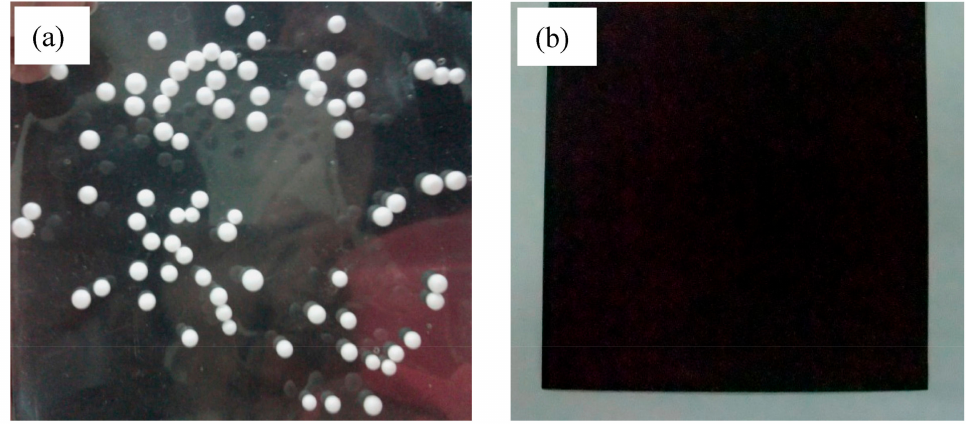
Figure 6. Antistatic tests: ( a ) pure WPU film, and ( b ) WPU/20wt% (PANDB/ χ -Al 2 O 3 ) conducting blend